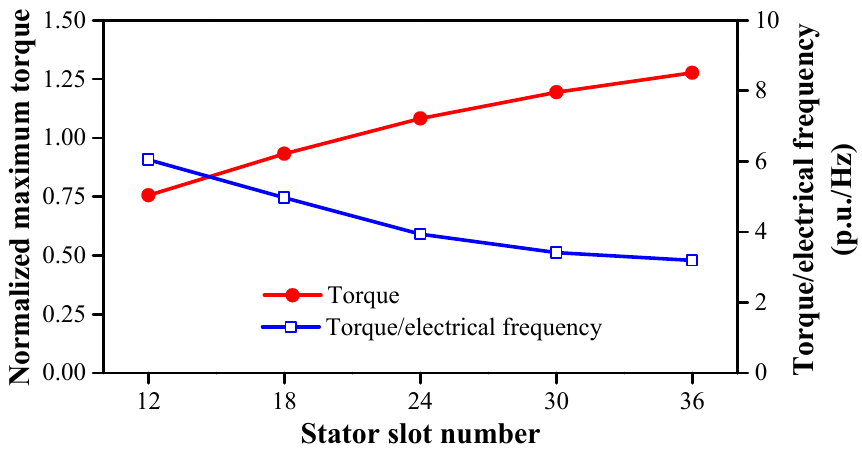
Figure 12. Maximum torque and torque/electrical frequency versus stator slot number at 600 rpm. The torque ripples of SSDPM machines are shown in Figure 13. The 12S8R4Pa, 24S16R8Pa, and 30S20R10Pa exhibit significantly higher torque ripple than other combi- nations. This is due to the fact that these combinations have the smallest least common multiple (LCM) of the rotor slot number and the stator slot number.